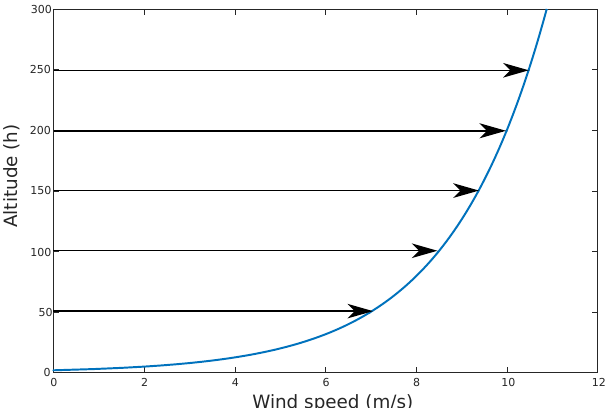
Figure 2. Typical shear profile that shows the increase of wind speed over as the altitude increases. The relationship is exponential between the two variables.